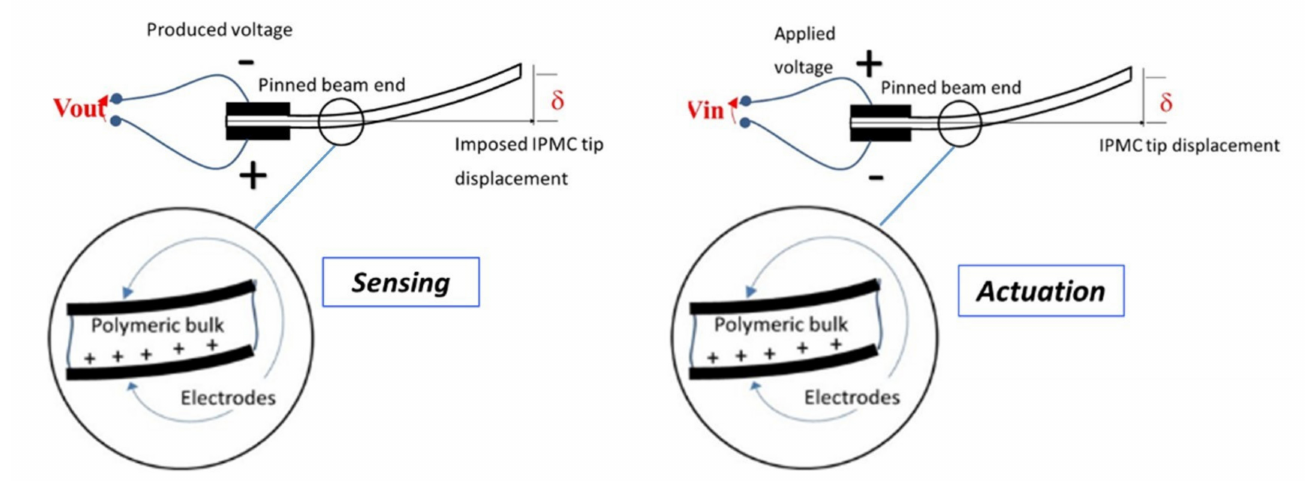
Figure 13. Schematic of the BC transduction mechanism in presence of cations. As it can be noted, the same tip deflection implies a voltage signal of opposite polarities for the sensing and actuating working modes. Moreover, when the tip of the sensor is deflected in the up direction, positive charges accumulate at the bottom face.